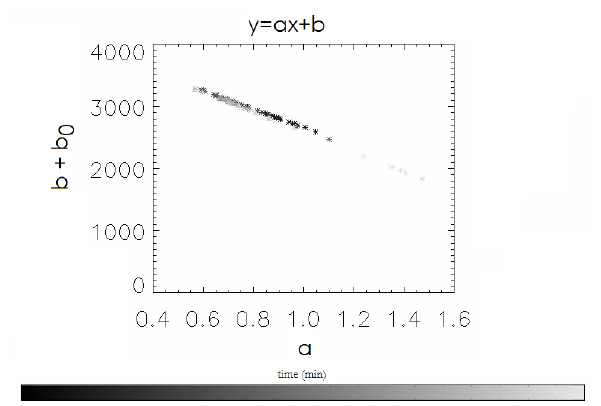
Fig. 014. Slope (a) and intercept (b) of the line defining the contrail Fig. 14. Slope (a) and intercept (b) of the line defining the contrail ( y = ax + b ) in each moment of its development. The level of gray ( y = ax + b ) in each moment of its development. The level of gray indicates the age of the contrail. indicates the age of the contrail.